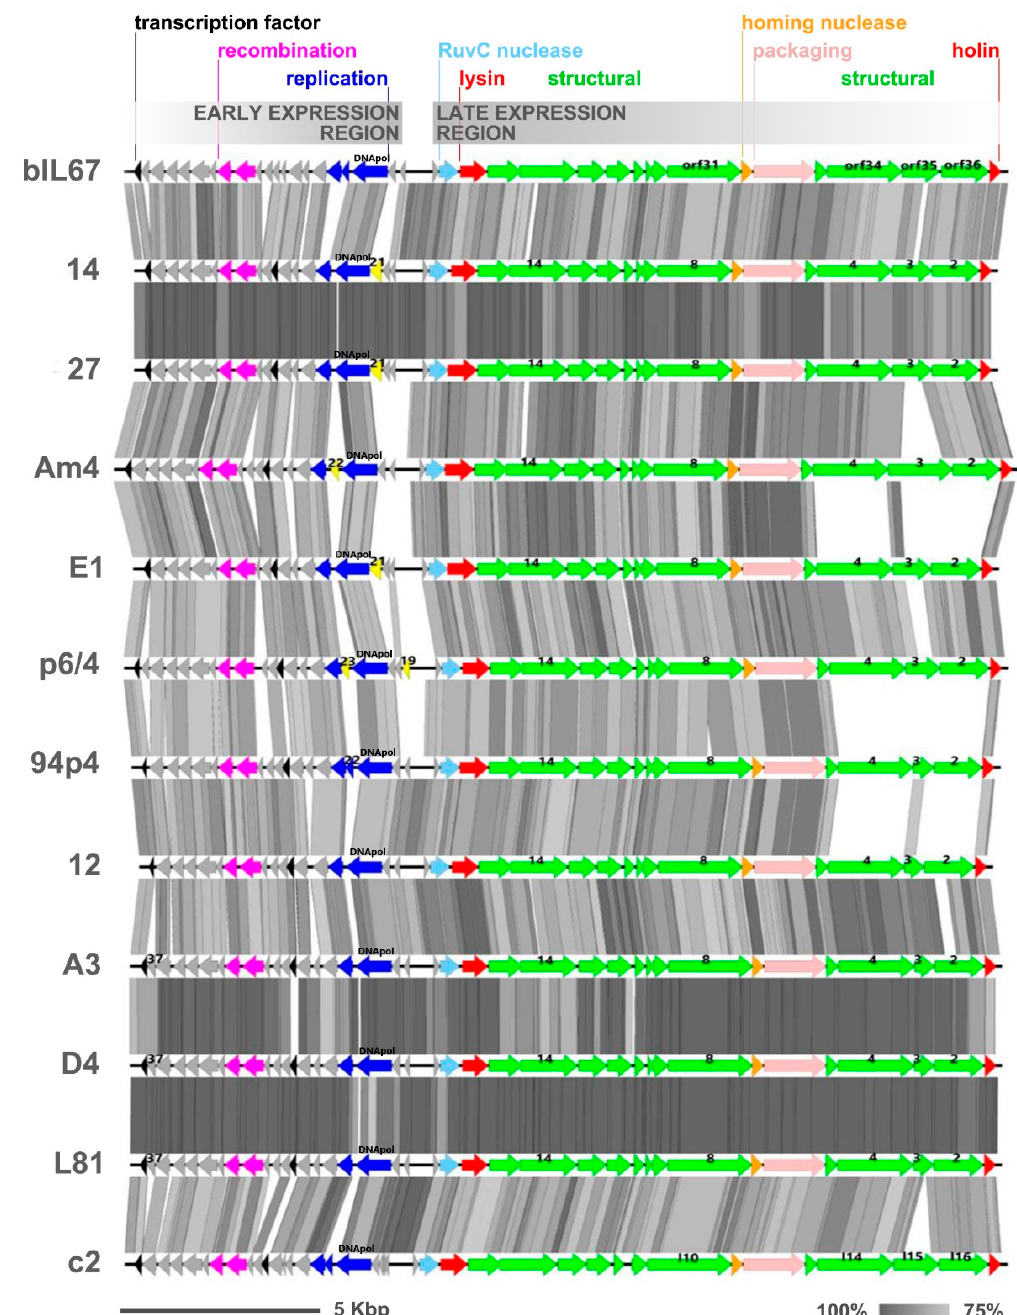
Figure 5. Synteny analysis of complete genomes of Lactococcus Ceduovirus phages sequenced in this study. The two transcriptional regions are oriented divergently to each other and are marked above the scheme. Arrows represent open reading frames ( orfs ); gray arrows indicate orfs of unknown function, yellow indicates unique orfs with unknown function, and the remaining colours indicate orfs with annotated functions. The genomes were aligned with respect to the position of the cos sites. Each genome is compared with the succeeding genome. The genomes of phages c2 and bIL67 are shown for reference. The gray shading between genomes indicates regions of similarity based on tblastx comparison. Numbers above individual orfs are given as reference to the genes discussed in the